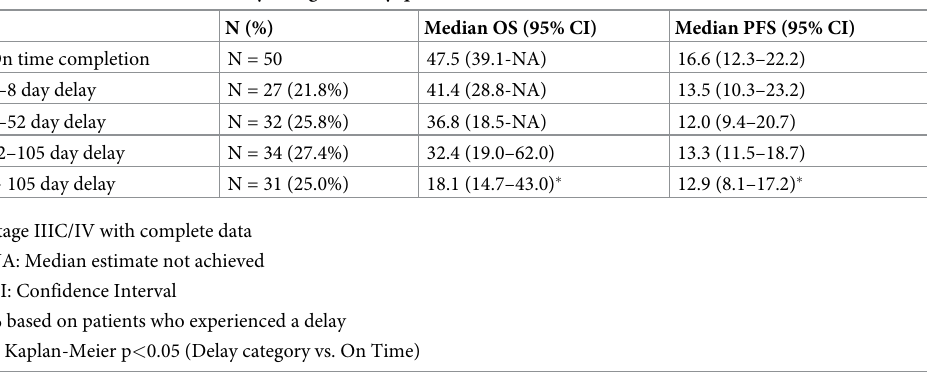
Table 3. Effect of treatment delay, categorized by